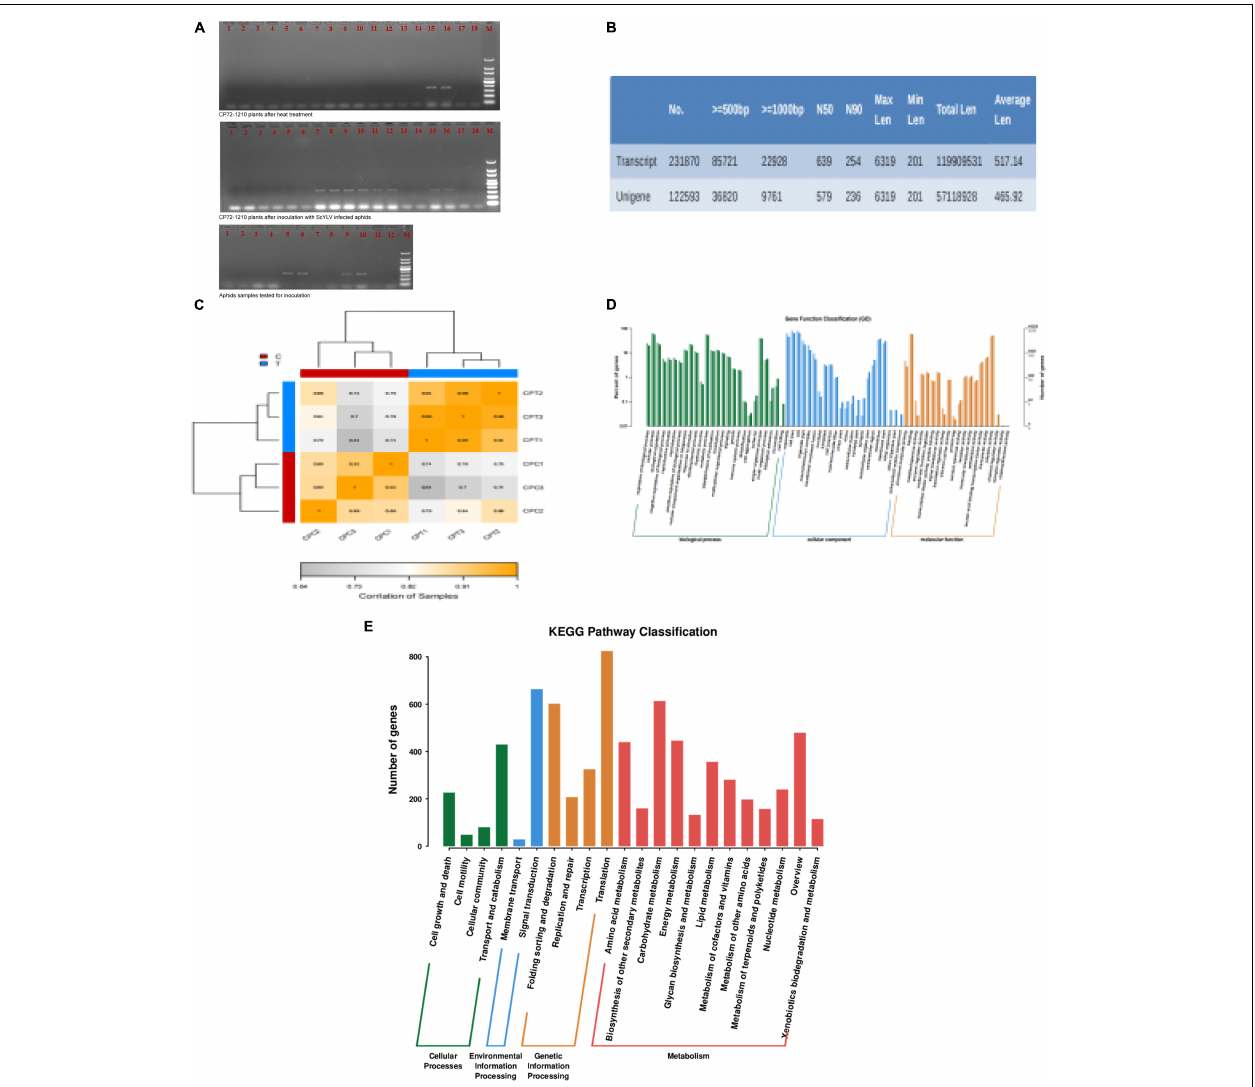
FIGURE 2 | Detection of ScYLV and analysis of RNA-Seq data. (A) Ethidium bromide-stained PCR products following amplification with primers YLSF- and YLSR from aphids and CP72-1210 plants. Lane designations: the upper two photos: 1–2: control plant 1; 3–4: control plant 2; 5–6: control plant 3; 7–8: treated Plant 1; 9–10: treated Plant 2; 11–12: treated Plant 3; 13–14: negative check (virus-free plant); 15–16: positive check, and 17–18: blank check (dd H 2 O); M (DNA ladder, Tiangen 100 bp). the photo below: 1–4: aphids fed with leaves of ScYLV-free CP72-1210; 5–6: aphids fed with ScYLV-infected leaves; 7–8: negative check (virus-free plant); 9–10: positive check; 11–12: blank check (dd H 2 O); M (DNA ladder, Tiangen 100 bp). (B) Transcript splicing results, including transcript and unigene data number. (C) CPT1, CPT2, and CPT3 correlation is all more than 0.94, CPC1, CPC2, and CPC3 also more than 0.89, which proves control and test group correlation meet the experimental requirements. (D) Analysis of GO enrichment for genes at the three stages of six samples. The green, blue, and yellow model represents genes number between biological processes, cellular component, and molecular function. (E) KEGG pathway enrichment analysis of significant genes. The red, yellow, green, and blue model represents metabolism, genetic information processing, environmental information processing, and cellular